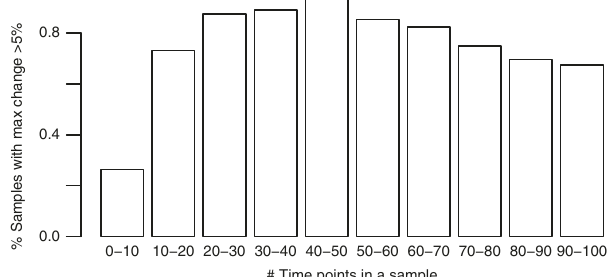
Fig. 7 Frequency of activity change by number of mutations. Proportion of tumours that have a signi fi cant change greater than 5% activity depending on the number of time points in a sample. Each bar corresponds to the range of number of time points in a sample; each time point contains 100